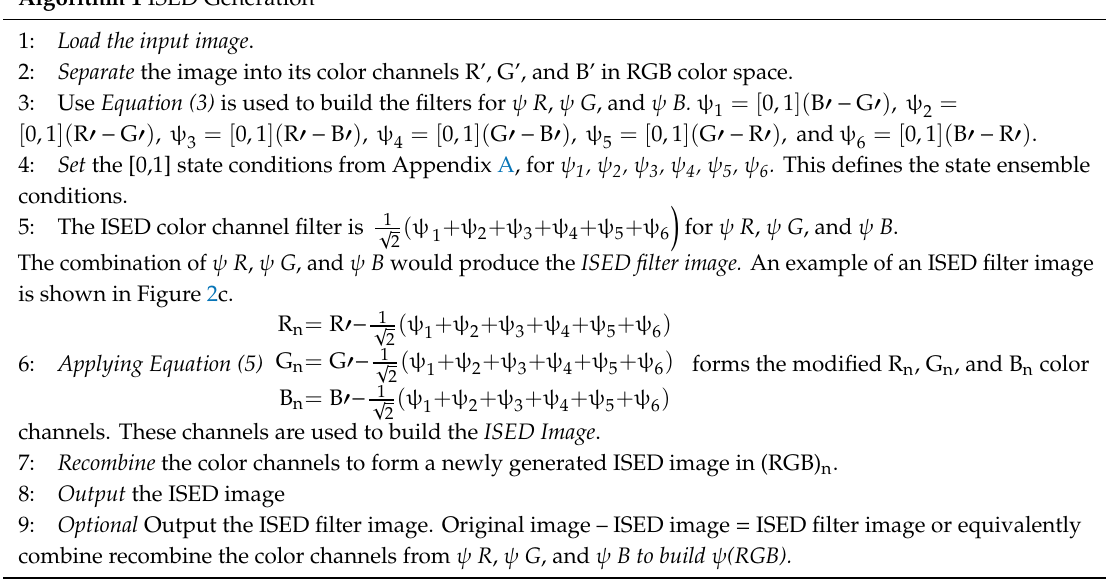
Figure 1. Algorithm flow chart for image state ensemble decomposition (ISED). Algorithm 1 ISED